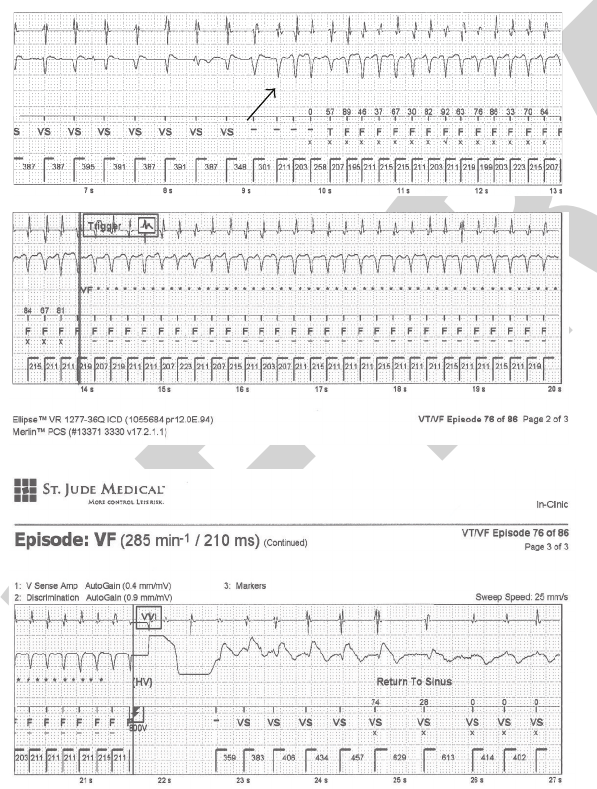
Figure 3: Reading from the implantable cardioverter defibrillator showing onset of ventricular fibrillation (arrow) at an average cycle length of 210 ms corresponding to a rate of 285 per minute. After the first shock (HV) delivered by the defibrillator, sinus rhythm is